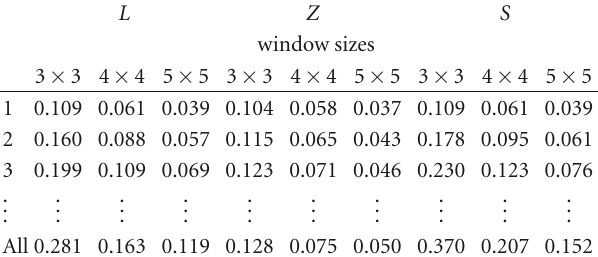
Table 5: Compression ratio for two-dimensional